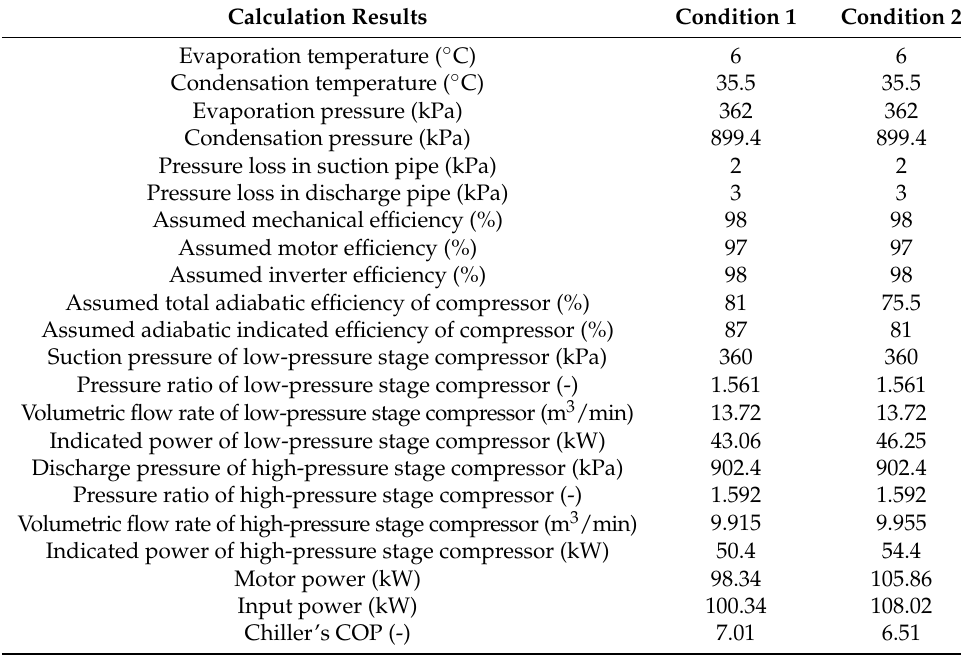
Table 1. Process and results of design point setting and